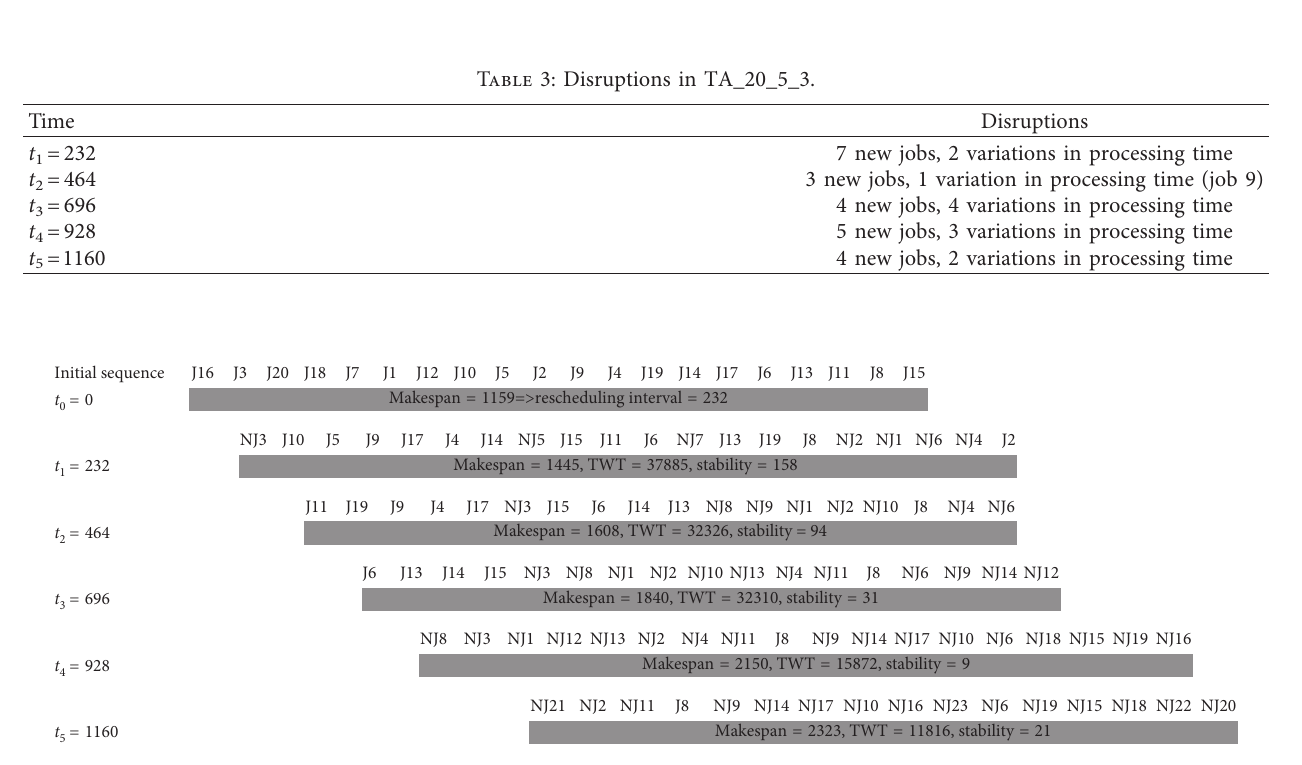
Figure 9: RIPG Pareto front in TA_50_20_1.